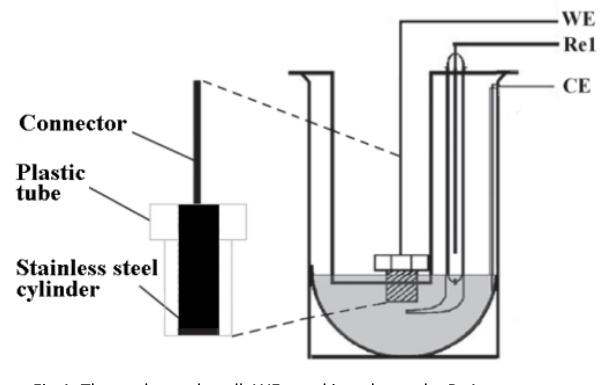
Fig.1: Three-electrode cell. WE: working electrode, Re1: reference electrode, CE: